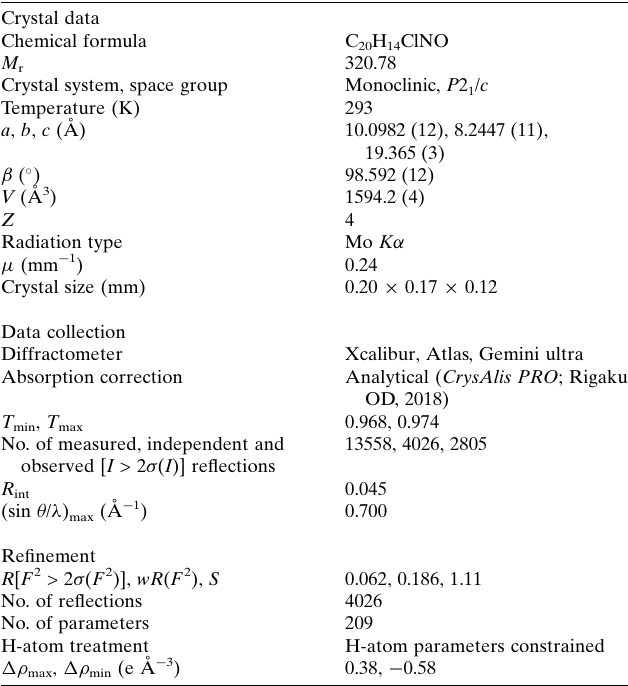
Crystal data Chemical